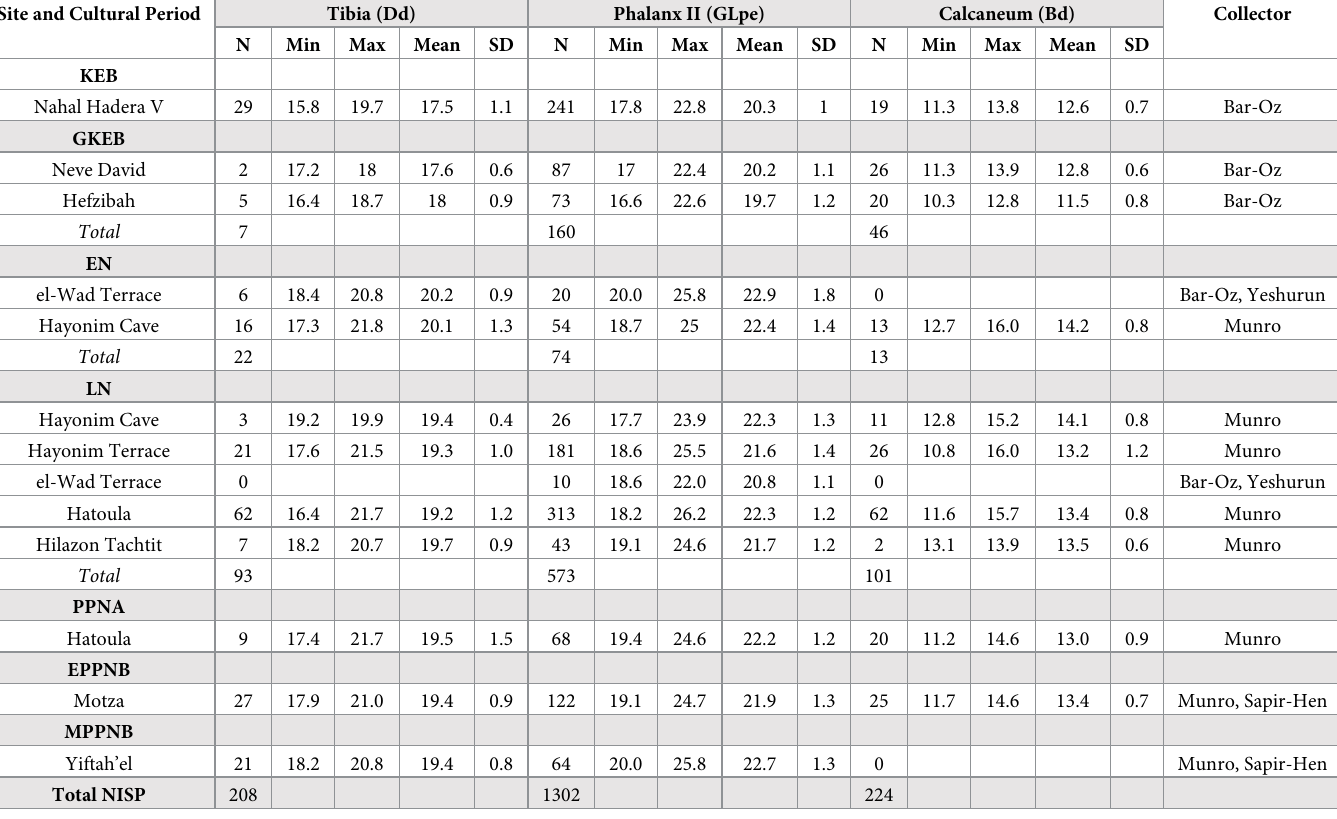
Table 1. Sample size, minimum, maximum, and average measurements of the Dd of the tibia, the GLpe of the second phalanx and the Bd of the calcaneum, and their standard deviation. Site and Cultural Period